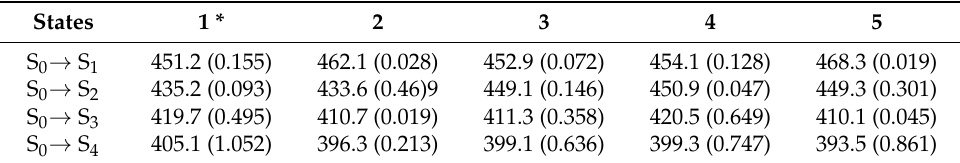
Table 5. Absorption wavelength λ in nm (oscillator strengths in brackets) of the first four excited states (S 0 → S i ) of the A ··· A PA1 dimer (same geometry numbering as in Table 2).